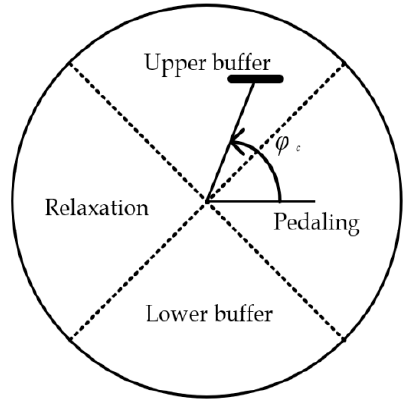
Figure 1. Bicycling phases.